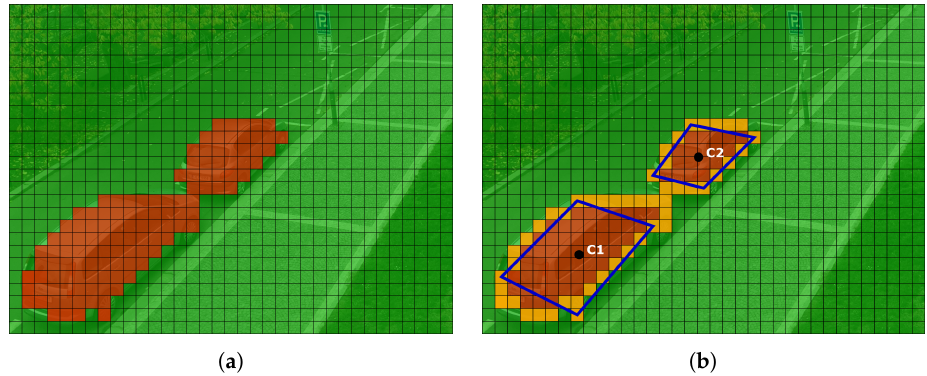
Figure 12. Determination of parking spaces position. ( a ) Blocks classified as a vehicle. ( b ) Boundaries of the blobs and detemination of the vehicle